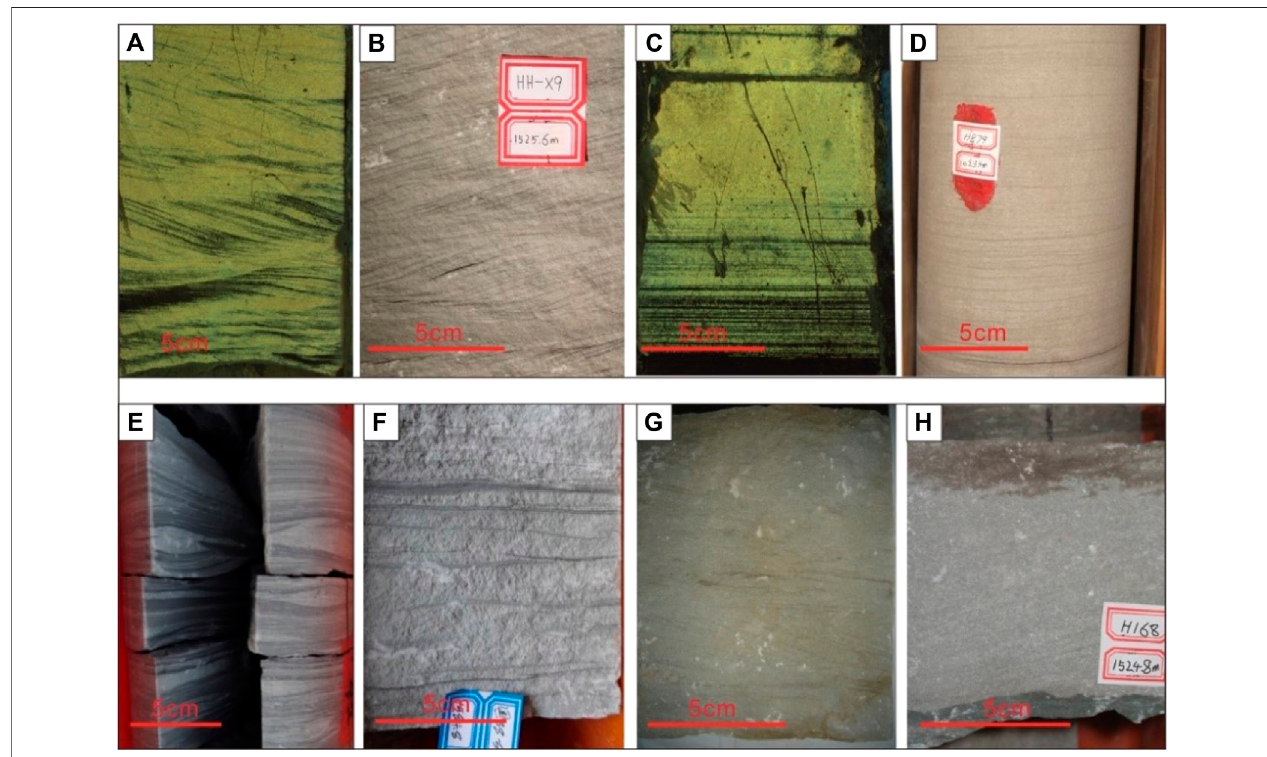
FIGURE4| Sedimentarystructureofthestudyarea: (A) HH75-X-4,1446.5m,ripplecrosslamination; (B) HH-9X,1525.6m,ripplecrosslamination; (C) HH75-X-4, 1456.8m, parallel bedding; (D) HH79, 1523.5m, parallel bedding; (E) HH-X9, 1520.4m, wavy bedding; (F) HE-88 – 2, 1584.8m, fl aser bedding; G : QE37 – 14, 1505.3m, trough cross bedding; (H) H168, 1524.8m, cross